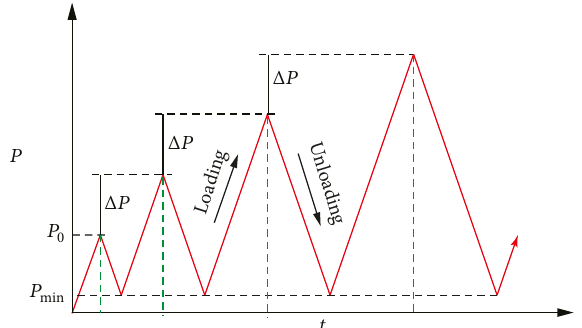
Figure 3: Loading path. The initial load 𝑃 0 = 40 kN, the lower limit 𝑃 = 10 kN, and the incremental load Δ𝑃 = 40 min